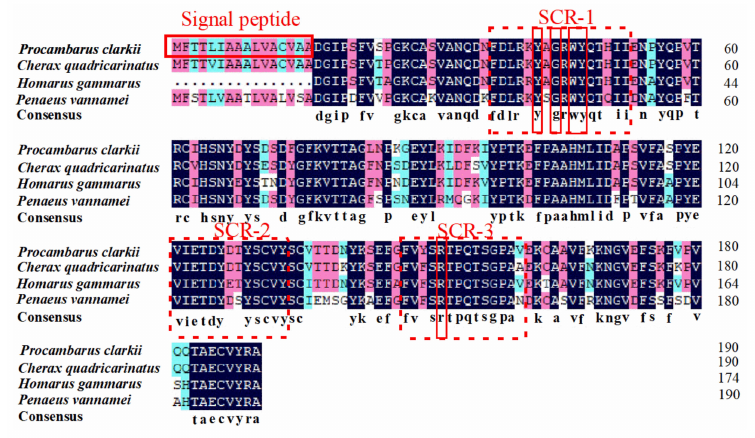
Figure 5. Amino acid sequence multiple alignments of crustacyanin from